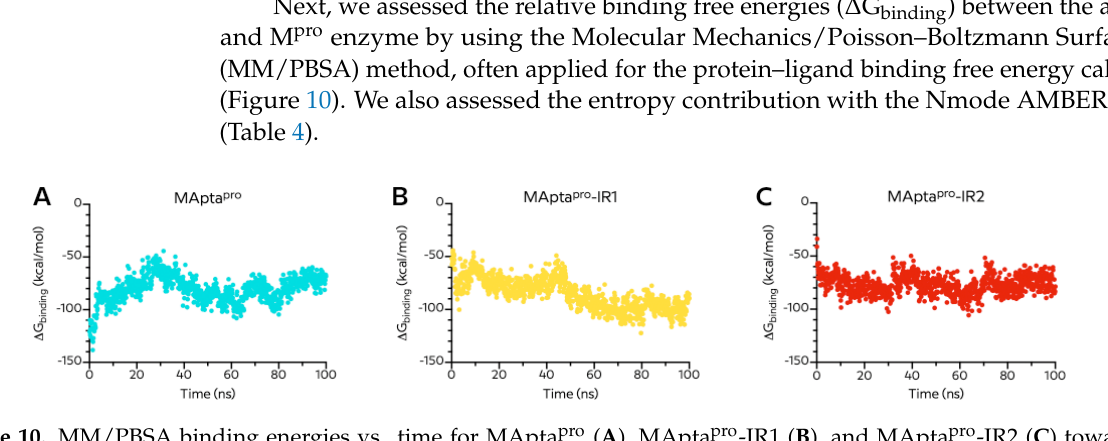
Figure 10. MM/PBSA binding energies vs. time for MApta pro ( A ), MApta pro -IR1 ( B ), and MApta pro -IR2 ( C ) towards SARS-CoV-2 main protease (M pro ). Table 4. Summary of M pro -Aptamers binding affinities. The Nmode was used to compute the entropy contribution. System